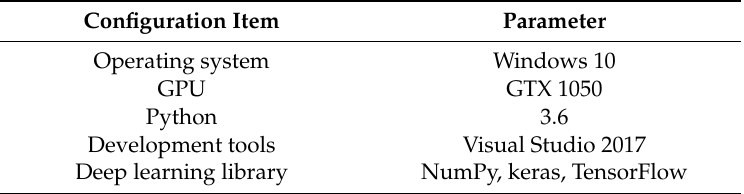
Table 3. Experimental environment specifications.